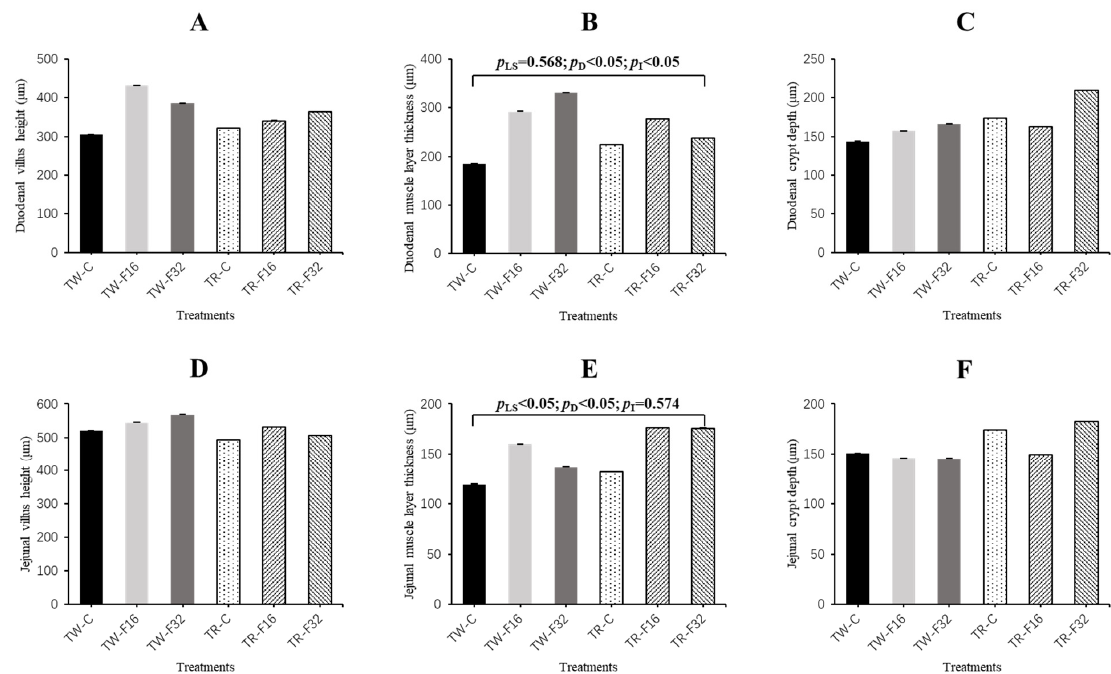
Figure 1. Duodenal villus height ( A ), duodenal muscle layer thickness ( B ), duodenal crypt depth ( C ), jejunal villus height ( D ), jejunal muscle layer thickness ( E ) and jejunal crypt depth ( F ) a ff ected by maternal folic acid supplementation. TW-CON, TW-F16 and TW-F32, twins born from ewes fed 0, 16 or 32 mg · (kg DM) − 1 folic acid in the control diet, respectively; TR-CON, TR-F16 and TR-F32, triplets born from ewes fed 0, 16 or 32 mg · (kg DM) − 1 folic acid in the control diet, respectively. p LS , p -value of litter size; p D , p -value of diet folic acid supplementation; p I , p -value of interaction e ff ects between litter size and folic acid supplementation.